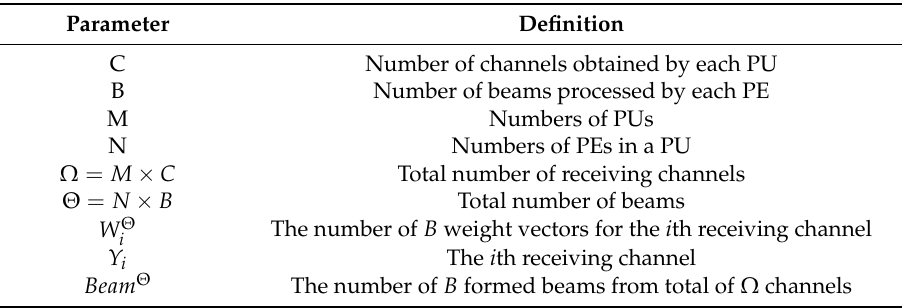
Table 1. Equation parameters.